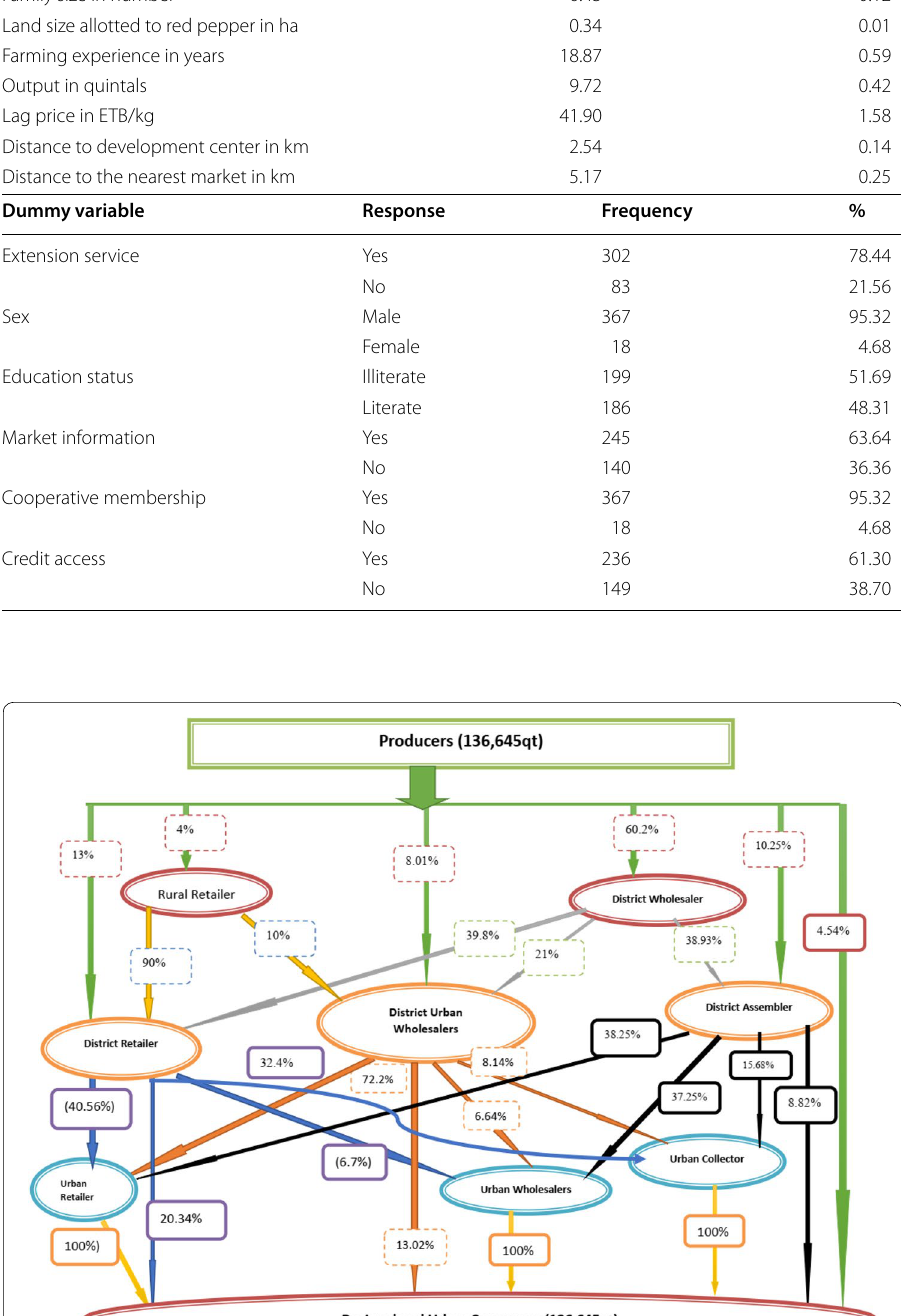
Table 1 Mean and proportion households’ characteristics ( N